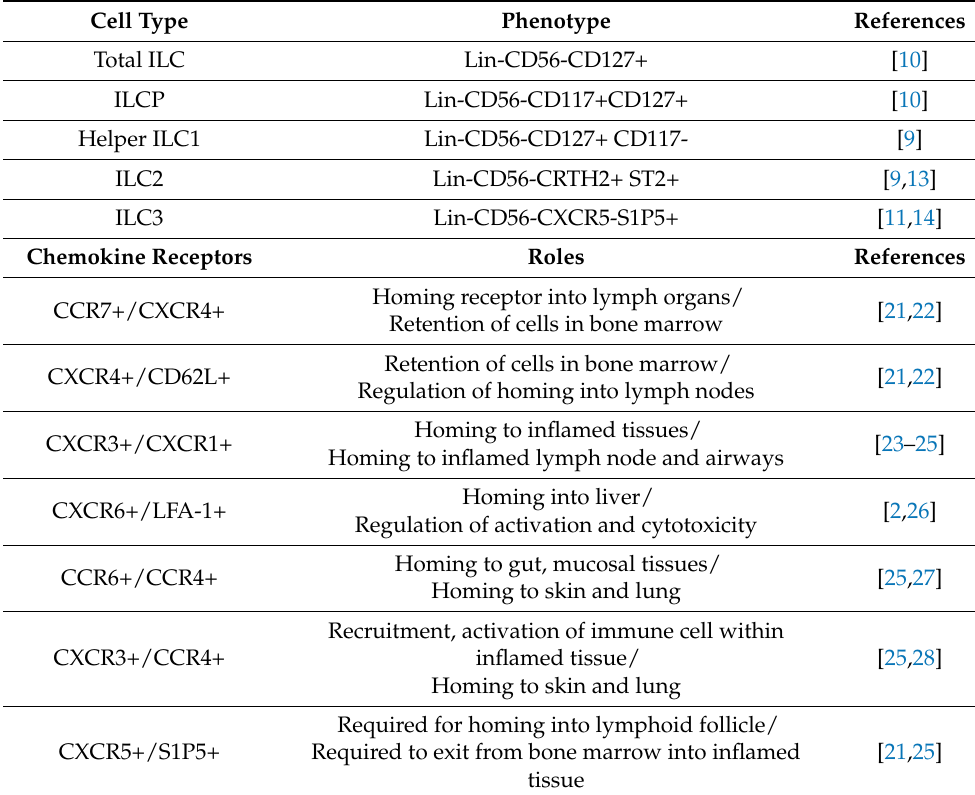
Table 1. Cell surface marker combinations used to identify the different ILC phenotypes and chemokine